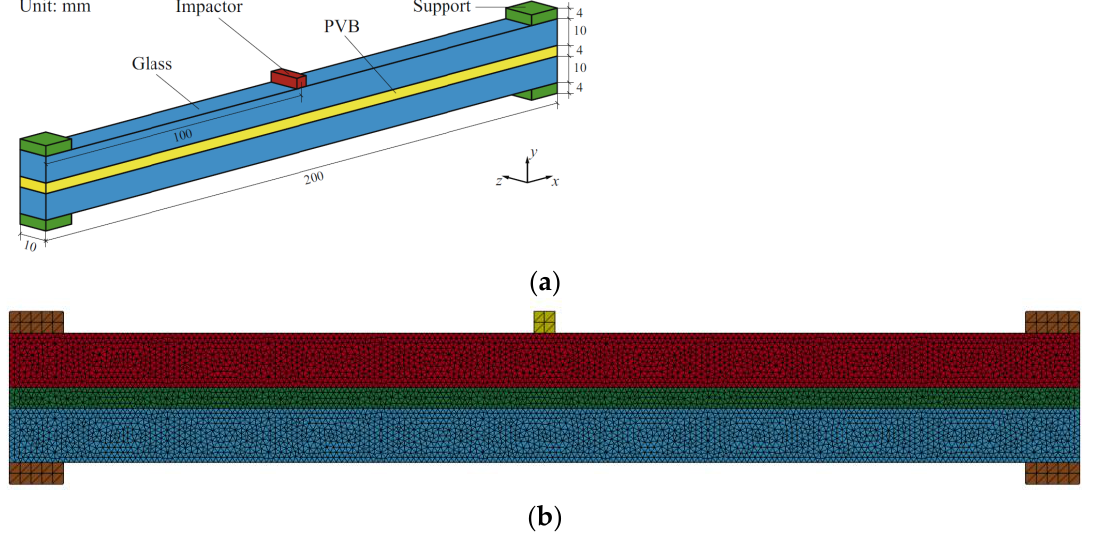
Figure 8. Configurations of the laminated glass: ( a ) Geometry (Adapted from Ref. [44]); ( b ) FDEM mesh. Table 3. Material properties for the FDEM analysis.